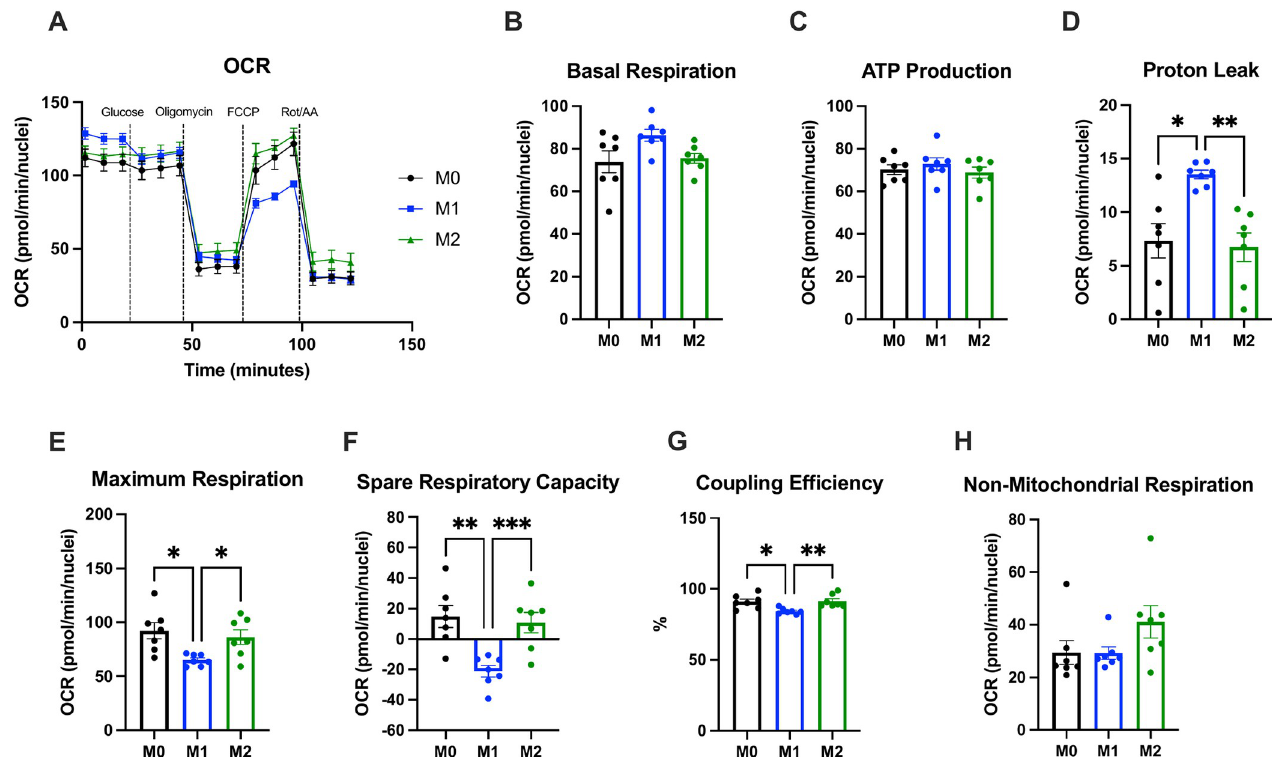
Fig 1. hMDM polarization induces changes in mitochondrial function. hMDM OCR (A) was measured using Seahorse Extracellular Flux. There were no significant differences between polarized hMDM subsets for basal respiration (B), ATP production (C), and non-mitochondrial respiration (H). M1 hMDMs had significantly higher proton leak (D) and significantly lower maximum respiration (E), spare respiratory capacity (F), and coupling efficiency (G) than M0 and M2 hMDMs. n = 7 biological replicates (3 males, 4 females) with 3–4 technical replicates per biological replicate and polarization state. Data are presented as mean ± SEM. � p < 0.05, �� p < 0.01, ��� p < 0.001 by matched one-way ANOVA with Tukey’s multiple comparisons test.